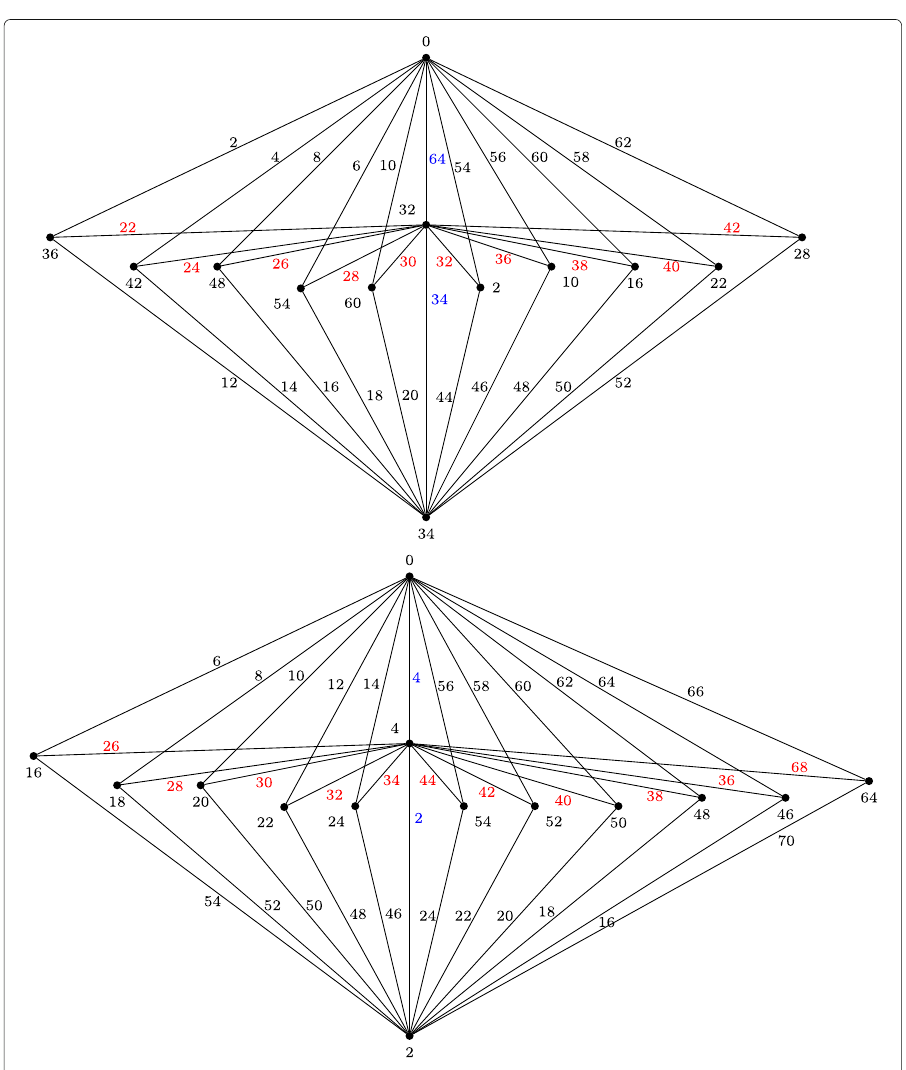
Fig. 6 An edge even graceful labeling of the graphs K 2 + K 1,10 and K 2 + K